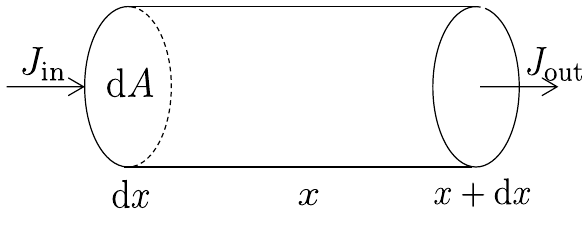
Figure 12. The one-dimensional medium transport system.